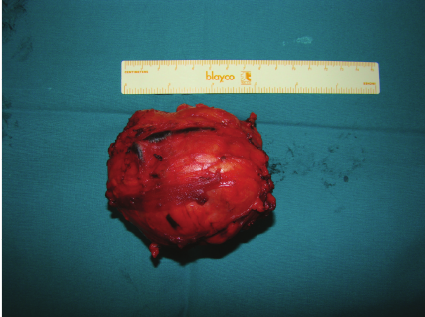
Figure 2: Gross specimen consisting of an ovoid tumor with a firm, fibroelastic white, tan cut